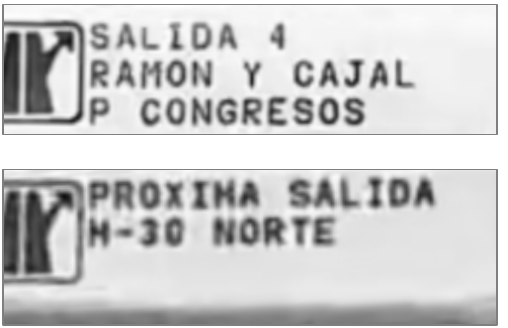
Figure 8. Some examples of OCR (part 2).